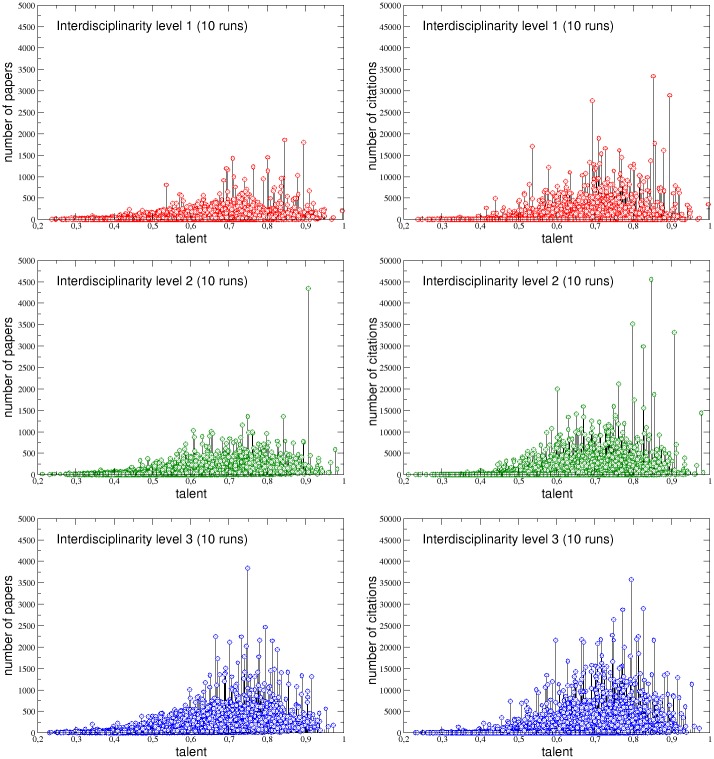
Papers and citations vs talent, collected over 10 replica runs of the same numerical simulation.Each circle in the figures represents the total number of papers (left column) or the total number of citations (right column) cumulated by each author of the three interdisciplinarity groups in each of the 10 runs, reported as function of the corresponding talent. These plots indicate in a clear way that the most successful individuals are never the most talented ones.